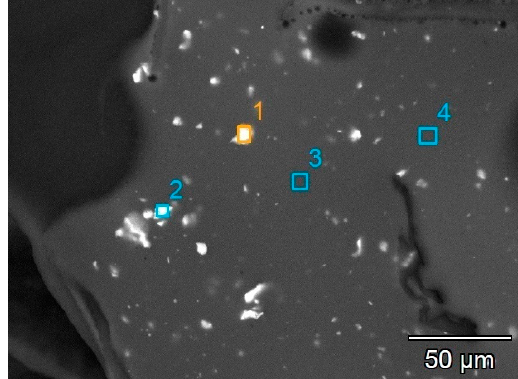
Figure 14. SEM image of C2 Pd/DNA after the Suzuki–Miyaura reaction with Hg(0). Pd/Hg: 1—1.14; 2—0.91; 3—0.87; 4—0.44.